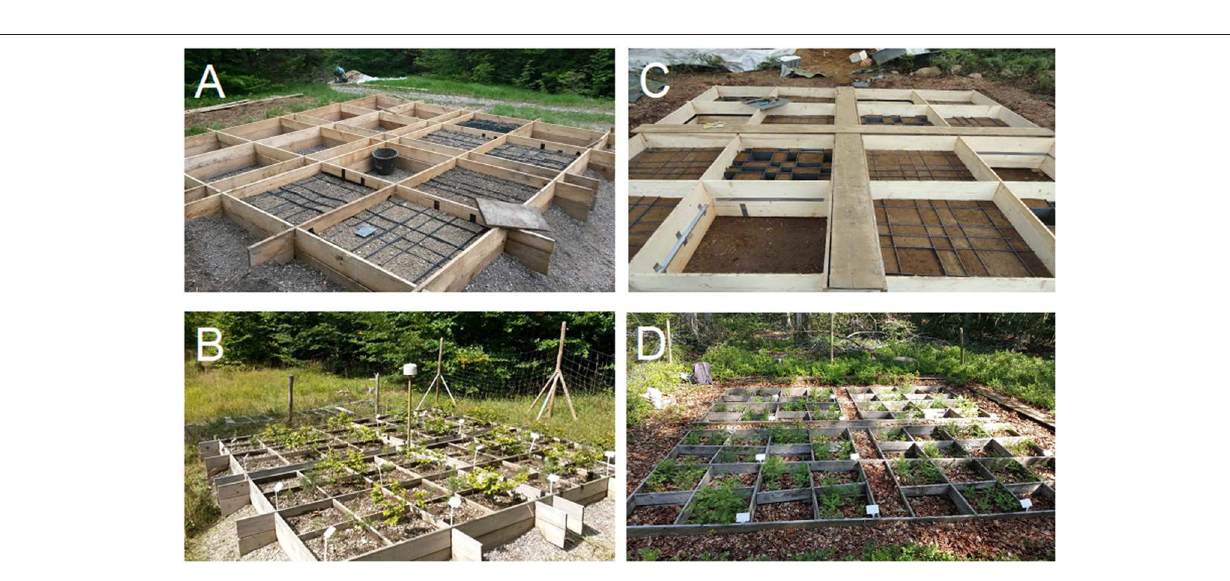
was divided into 4 squares as described before for Achenpass